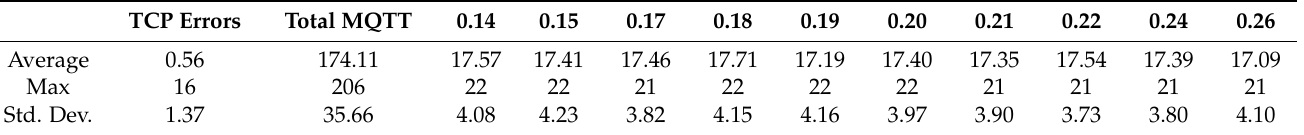
Table 1. Server message queuing telemetry transport (MQTT) packet load per second in the 10 nodes scenario.